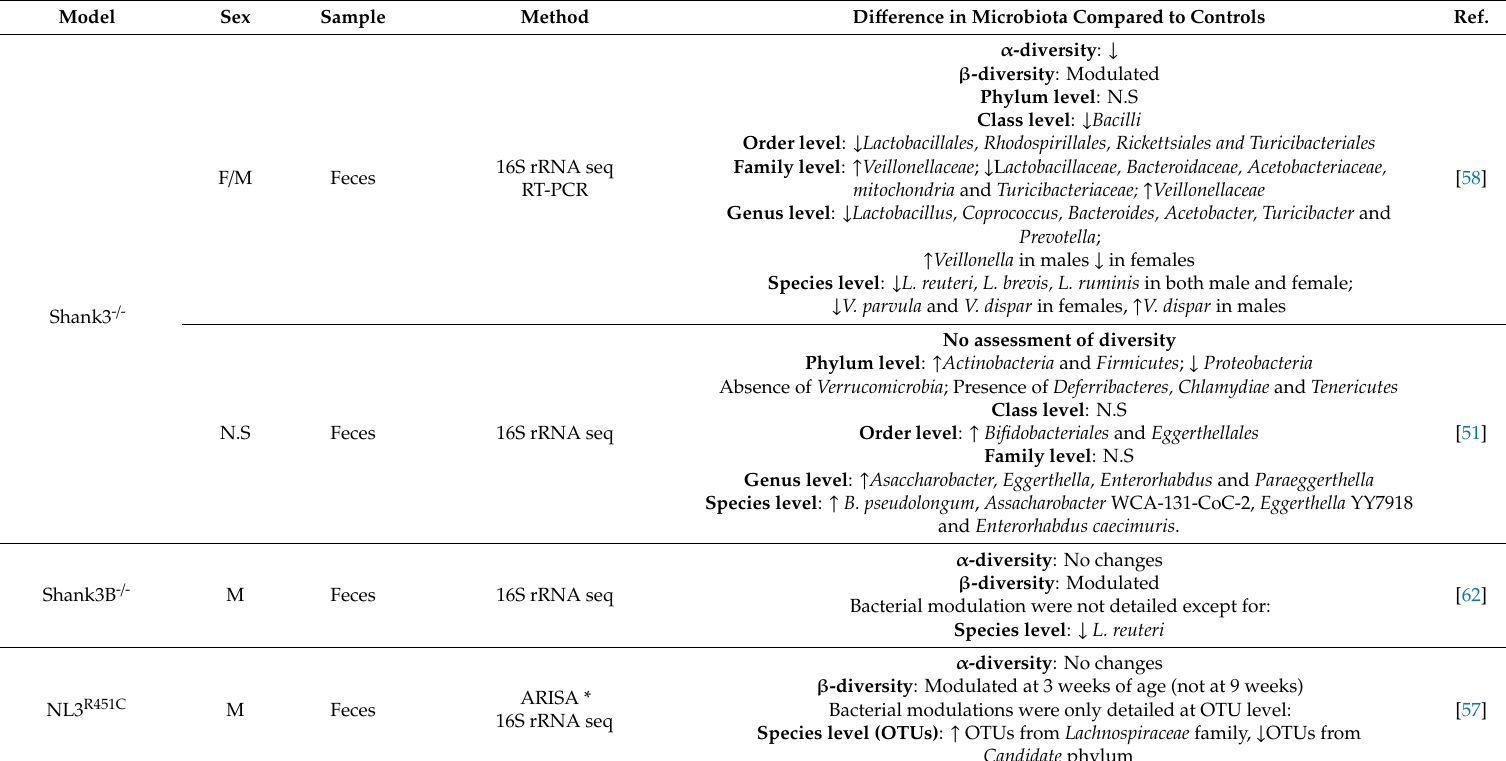
Table A1. Microbiota modulations in genetic models of